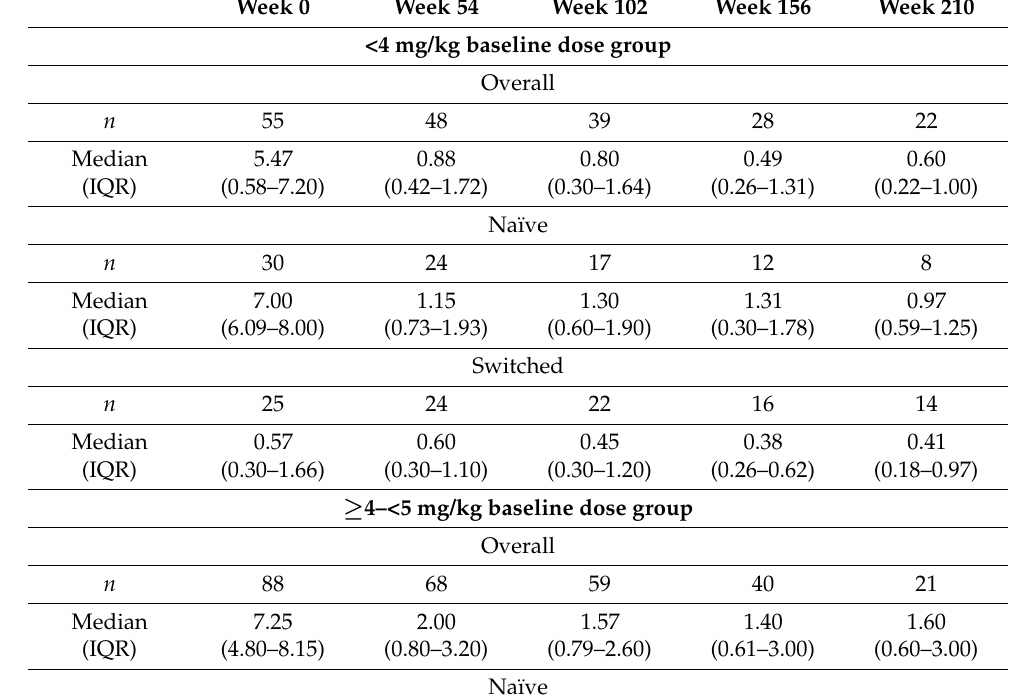
Table 2. Median (IQR) BASDAI scores 1 by treatment group for baseline dose analysis